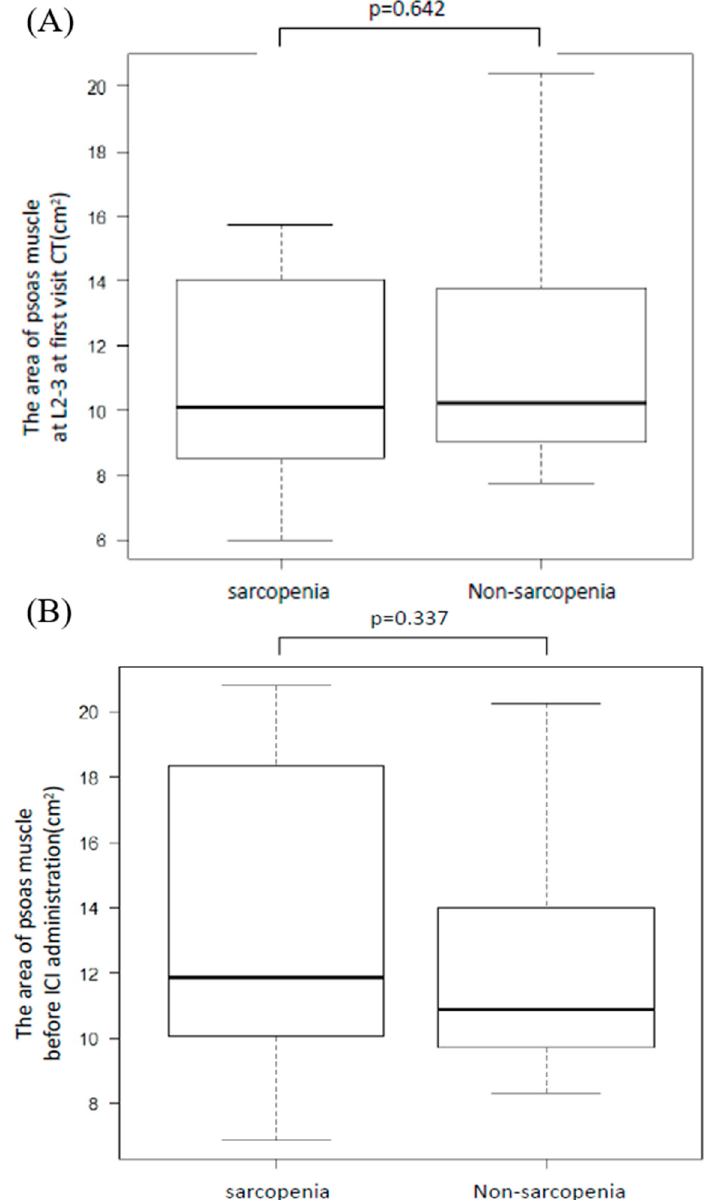
Figure 2. Area of psoas major muscle at the L2–L3 position for the sarcopenia and non-sarcopenia groups. We divided patients into sarcopenia or non-sarcopenia groups and compared the area of the psoas major muscle. There was no significant difference at the first visit CT ( A ) or before ICI treatment ( B ).